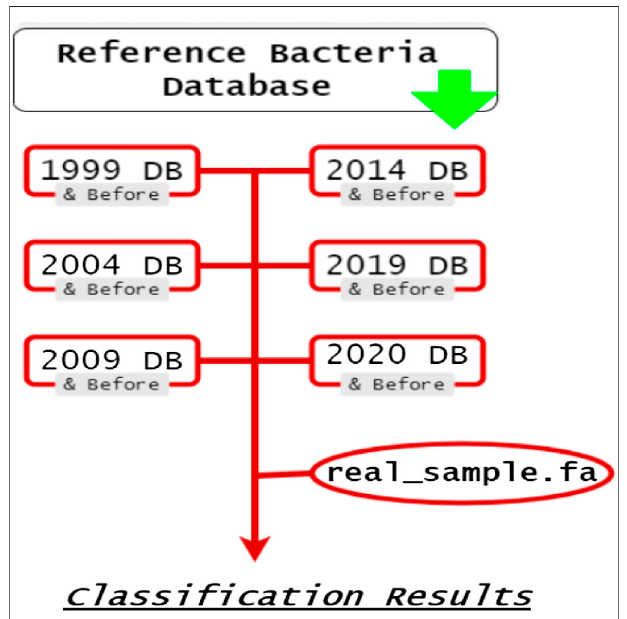
FIGURE 1 | A proof-of-concept diagram for your